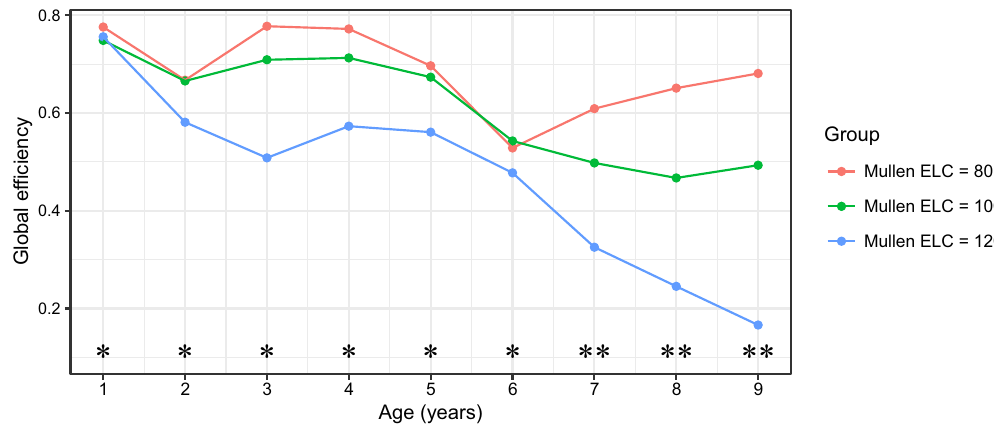
Figure 4. Global efficiency of SCNs at ages 1–9 with one year apart for three different ELC scores 80, 100, 120. Significance of differences is indicated separately for each comparison (*0.05, **0.01).